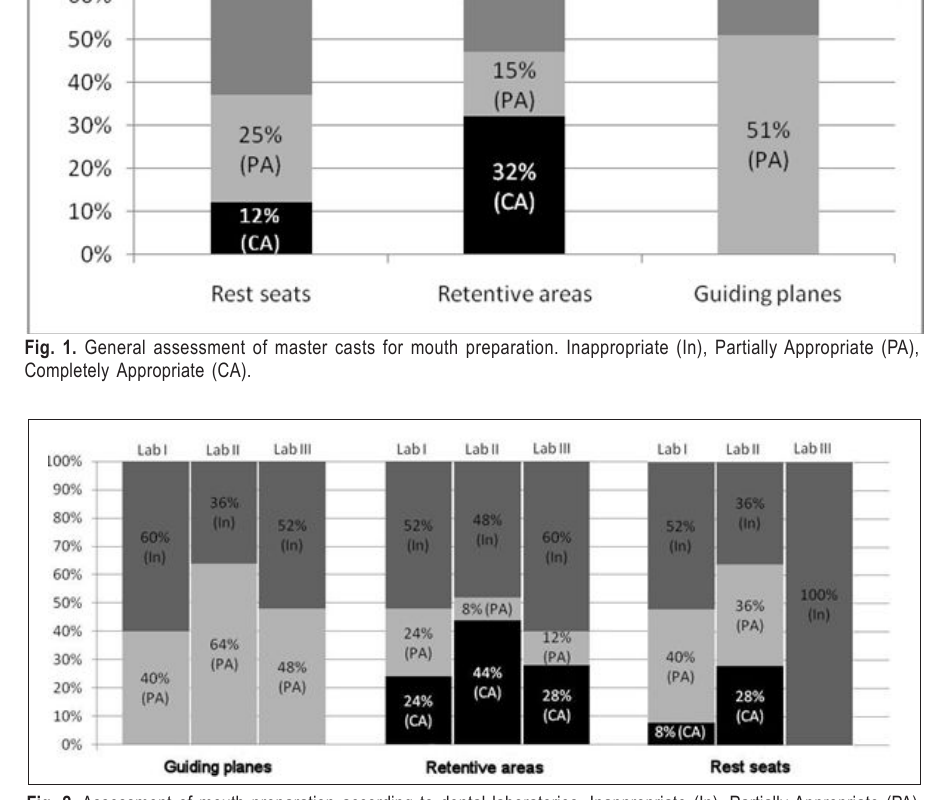
Fig. 2. Assessment of mouth preparation according to dental laboratories. Inappropriate (In), Partially Appropriate (PA), Completely Appropriate